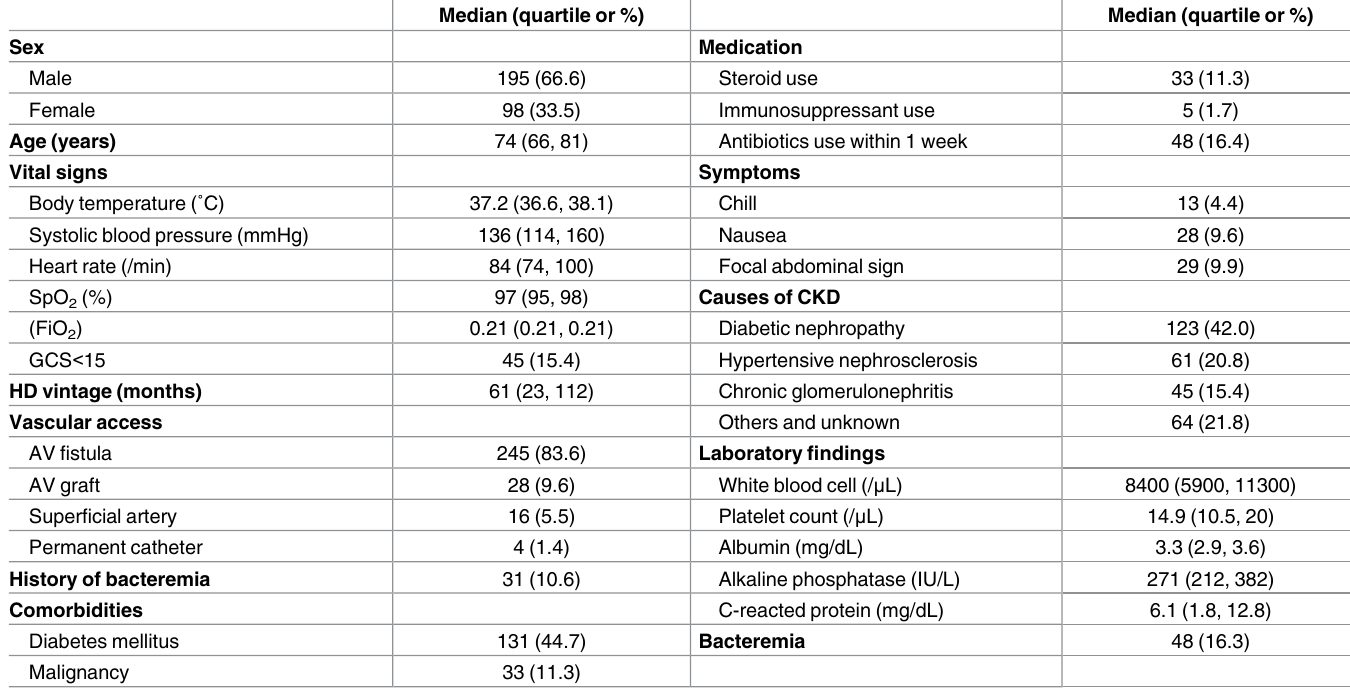
Table 1. Baseline characteristics (N = 293).